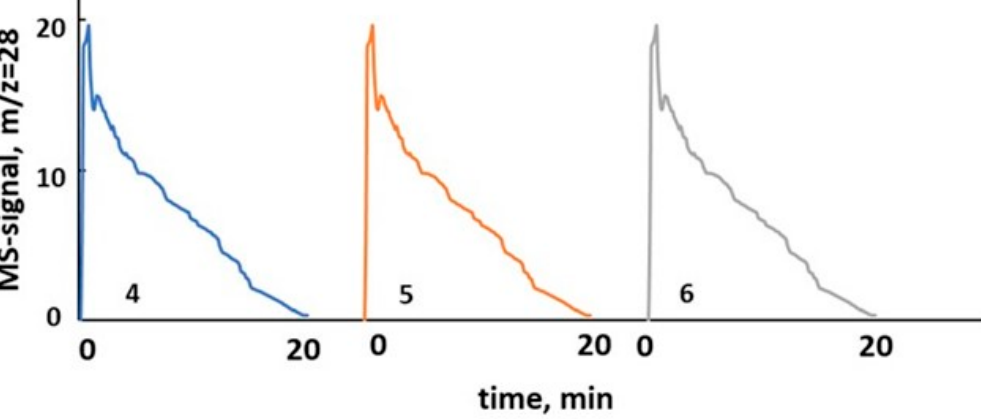
Figure 15. CO peaks recorded in isothermal RWGS-CL experiments with 6%K/BaFeHAl catalyst (T = 450 °C, catalyst loading 0.117 g).